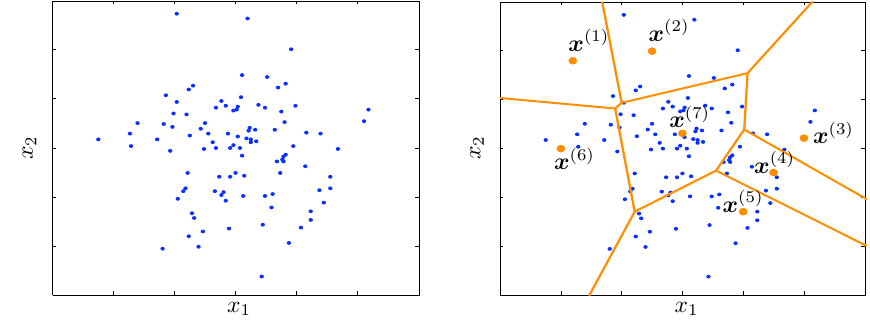
Fig. A1. Implementation of the stochastic quantization method with d = 2 and N = 7. The blue points are a sample of the input random vector X = (X 1 ,X 2 ) ; the orange points x ( 1 ) ,..., x ( 7 ) are the possible values of ˆ X , which is a discrete approximation of X . The orange lines n o x ( 1 ) ,..., x ( 7 ) define the Voronoi regions generated by the set : the region associated to x (i) contains the sample points which are closer to x (i) than to any other of the orange